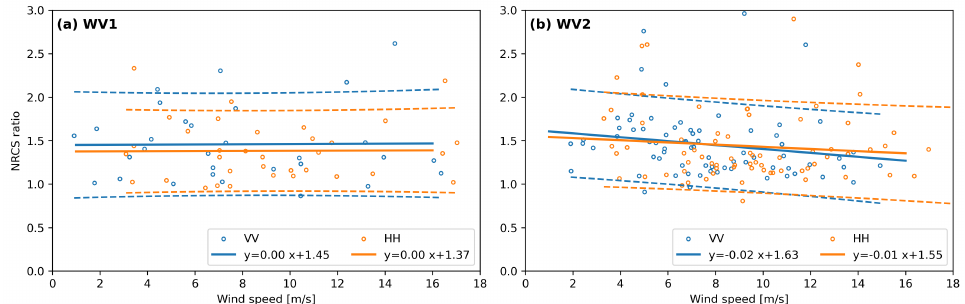
Figure 5. NRCS ratio of open water to the wave in ice within the same SAR scene for ( a ) WV1 and ( b ) WV2. The two polarizations (VV and HH) are shown in blue and orange, respectively. Solid lines represent the line regression with the annotated analytical form and the dashed curves are the 90% prediction interval for each polarization.